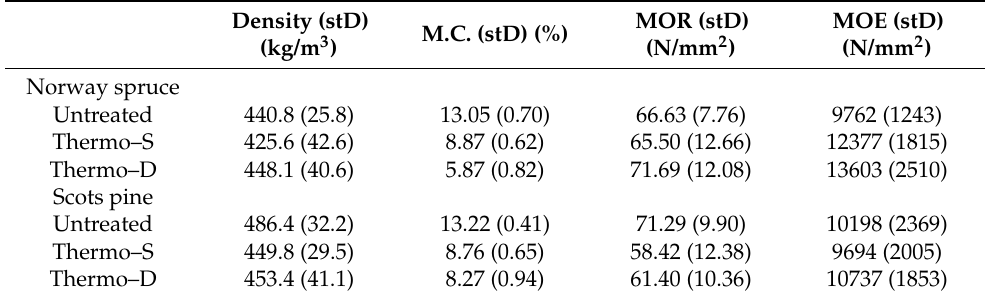
Table 3. Overview of selected properties of unmodified and modified Norway spruce and Scots pine specimens. stD—standard